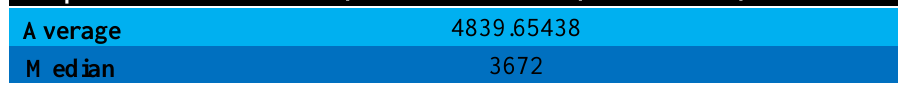
Table 7. Most significant measures obtained for temperature control